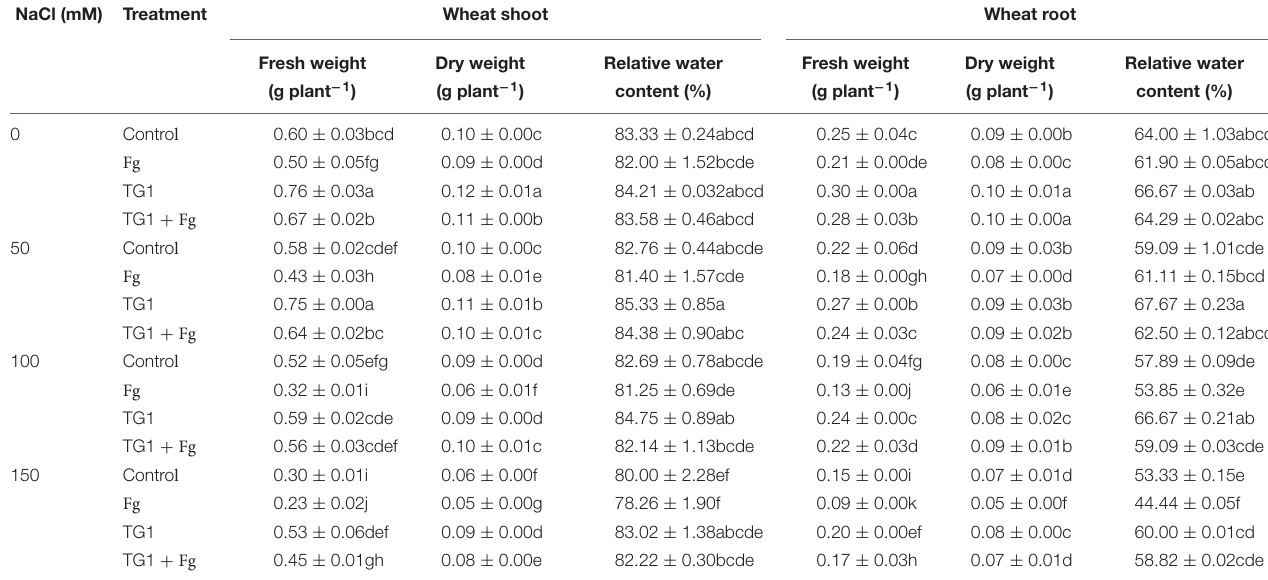
TABLE 1 | Effect of T. longibrachiatum (TG1) on wheat seedling biomass and relative water content under F. pseudograminearum (Fg) and different salt stresses. NaCl (mM) Treatment Wheat shoot